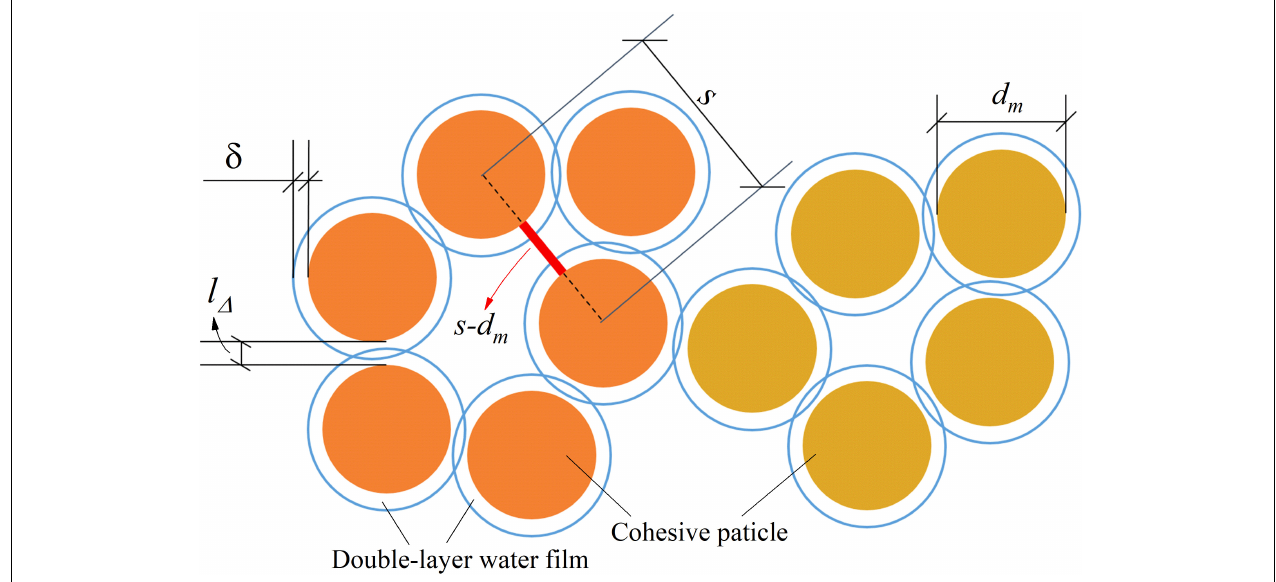
FIGURE 1 | The distinction between a separation distance between two contacted particles ( l (cid:49) ) and a separation distance between two neighboring particles not contacted with each other ( s − d m ).